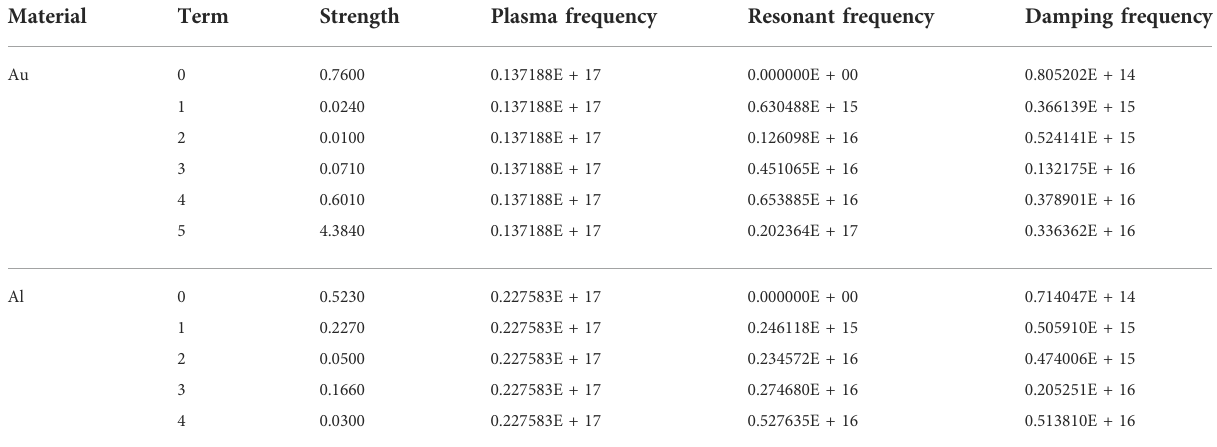
TABLE 1 Plasmonic parameters used for the metallic nanoparticles.